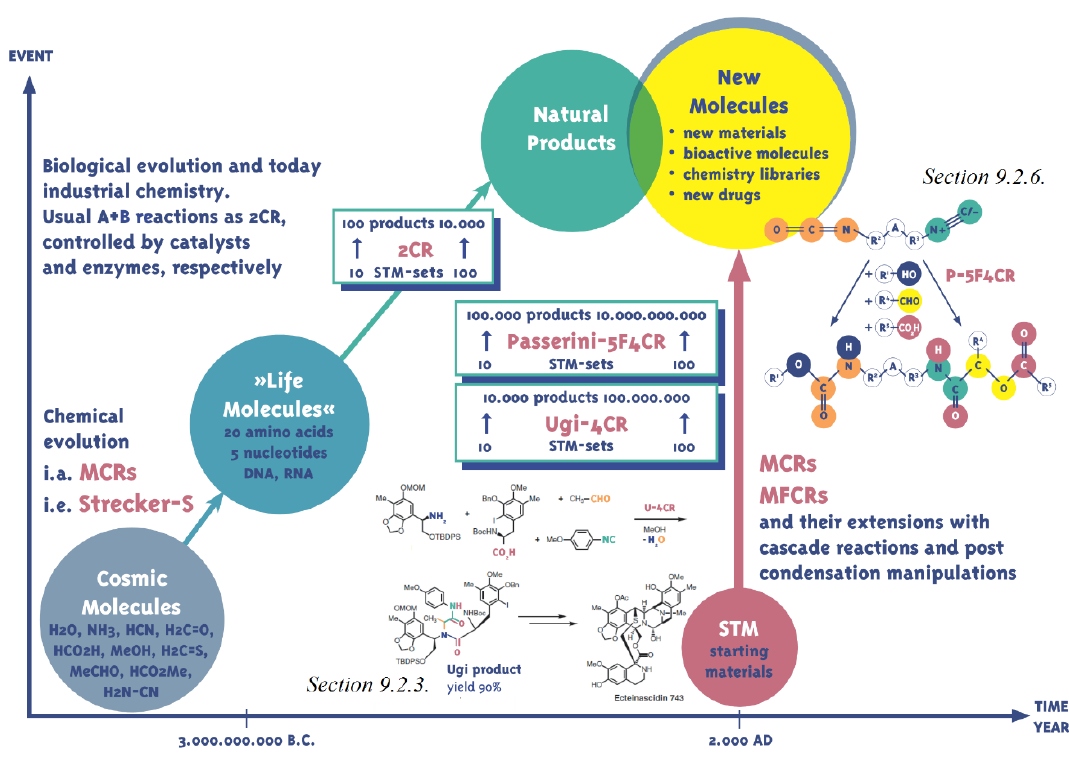
Figure 2. Significant systemic differences in syntheses of chemical products by means of two- and multicomponent reactions, respectively.